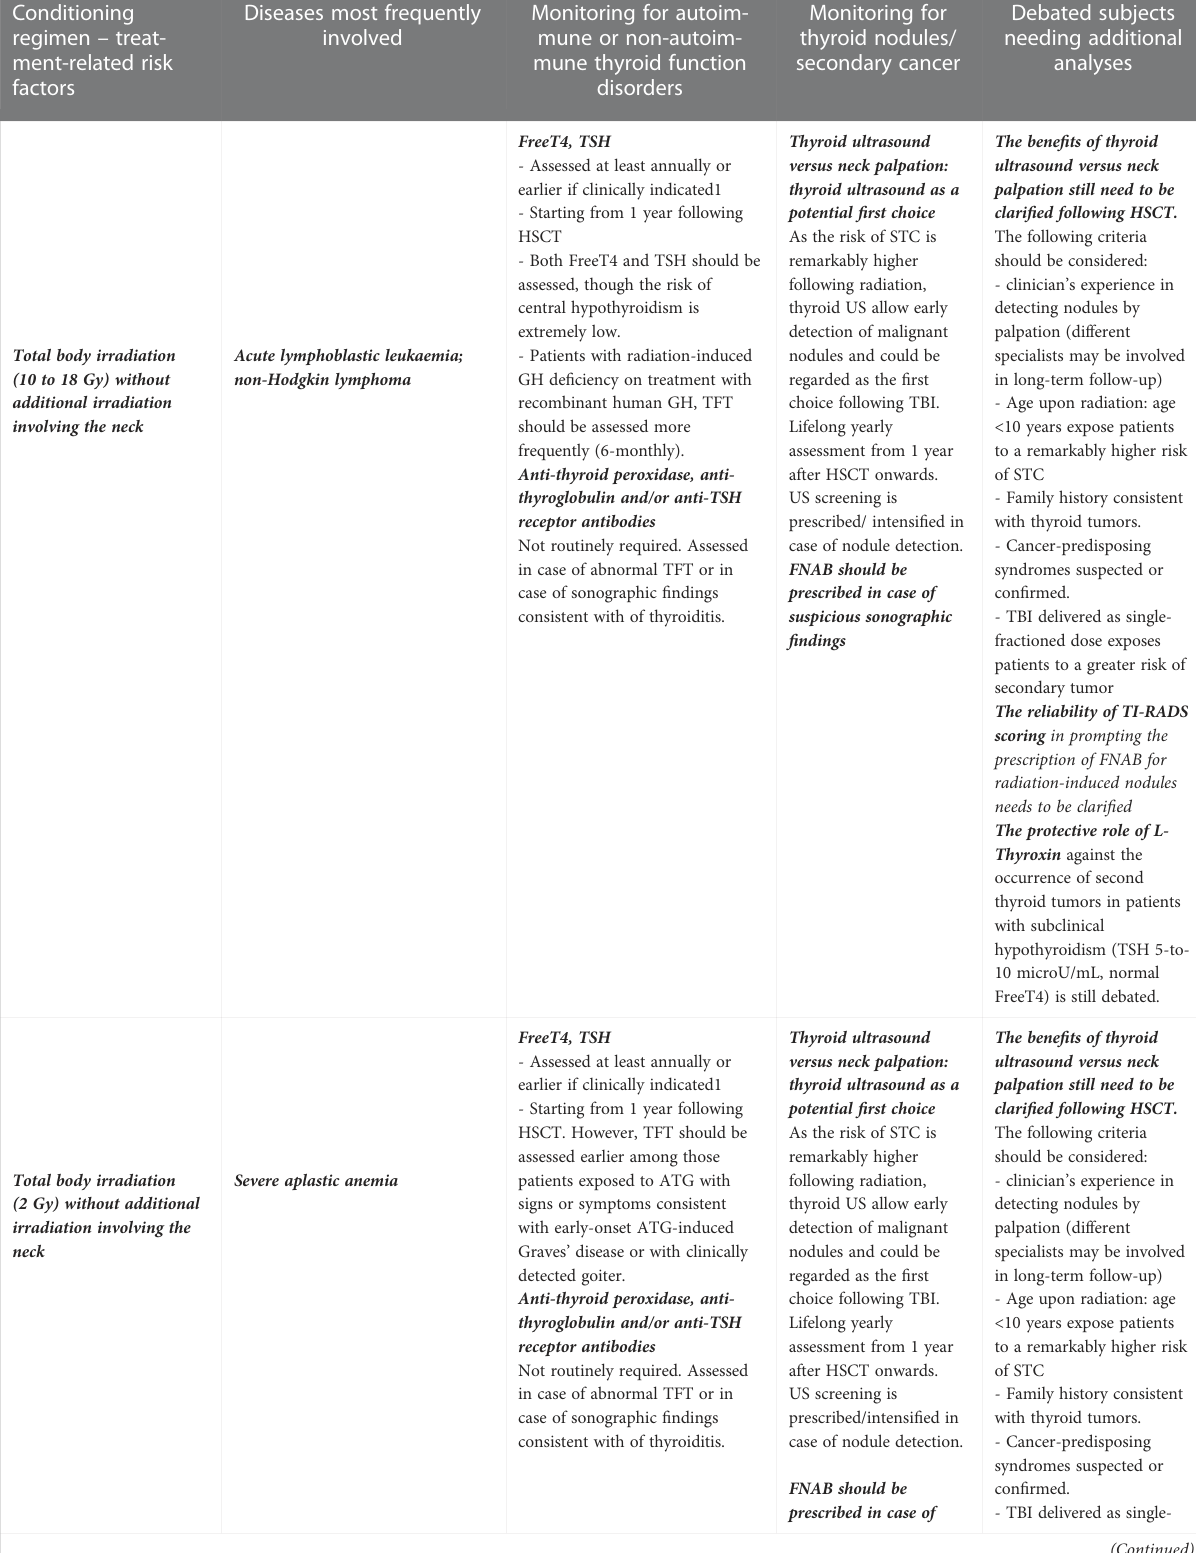
TABLE 2 Recommendation for screening and management approach of thyroid disorders following haematopoietic stem cell transplantation, by conditioning regimen and/or additional potentially detrimental factors. Conditioning regimen –